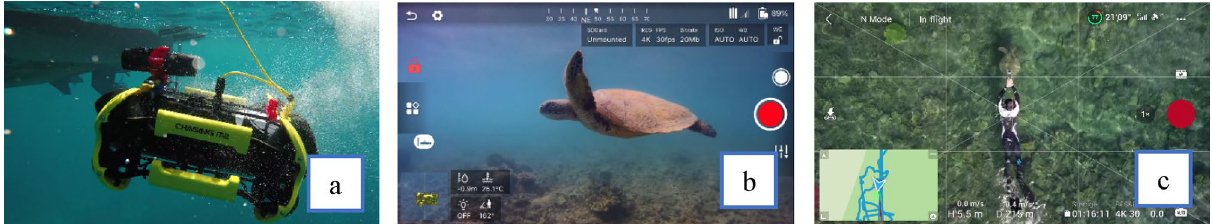
Figure 1. ( a ) ROV with external camera launched from the rigid inflatable vessel. ( b ), ROV user interface showing sea turtle applying general swimming routine, ( c ) Sea turtle swim speeds from GoPro GPS,